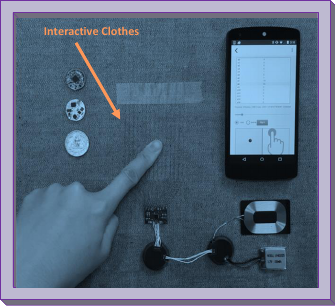
Figure 45. BackCom-based interactive clothing.